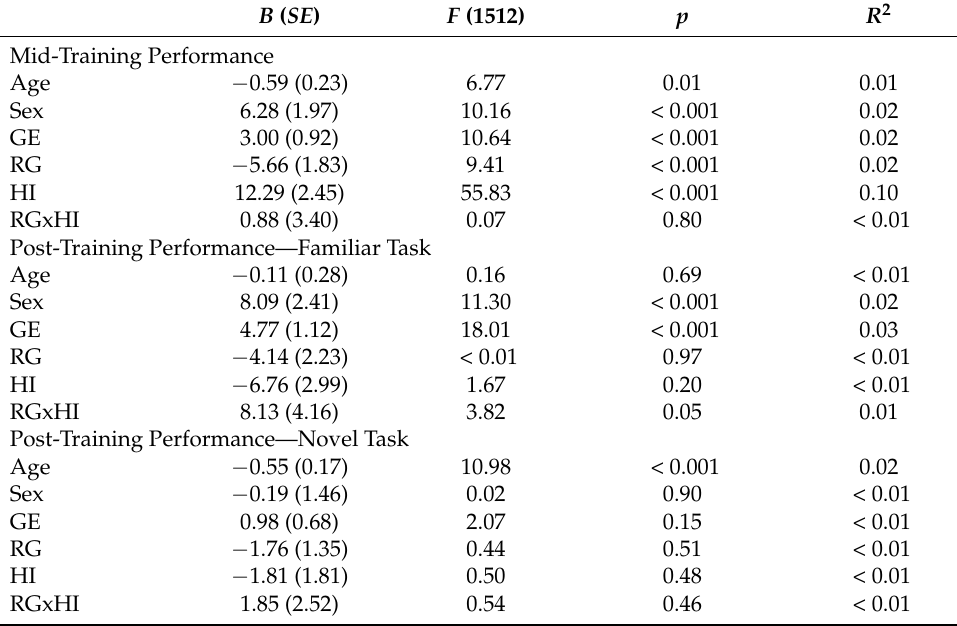
Table 2. Hypothesis testing of MANOVA results by learning